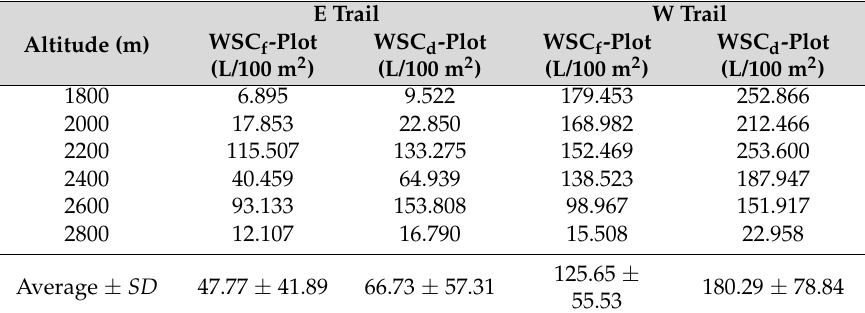
WSC f -plot; water storage capacity of fresh samples in a plot, WSC d -plot; water storage capacity of dried samples in a plot, SD ; standard deviation.